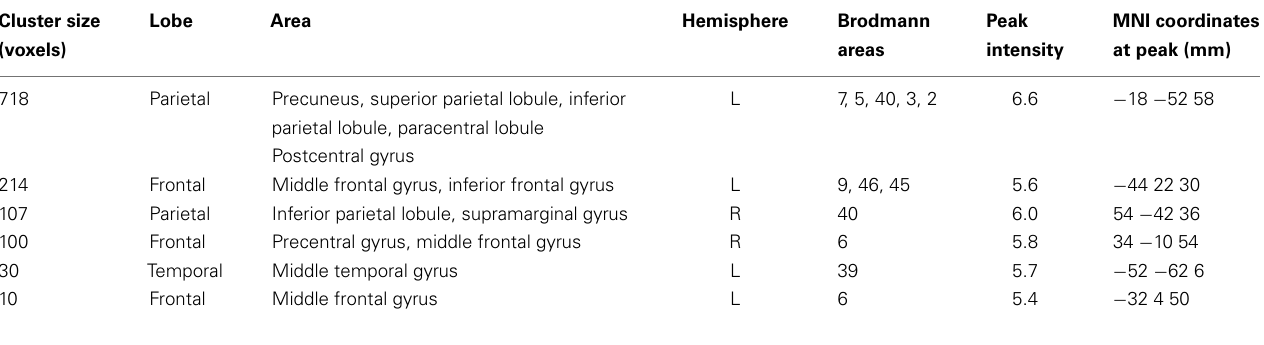
FIGURE 2 | Significant (active > baseline) regions of activation during speech preparation across all subjects ( n = 24) . Four clusters of activation survived correction (FWE) in the left hemisphere and two in the right. Description of the locations is available in Table 2 . Table 2 | MNI coordinates and anatomical labels of FWE-corrected brain sources thresholded at T > 5.2 as revealed by task-baseline contrast . Cluster size